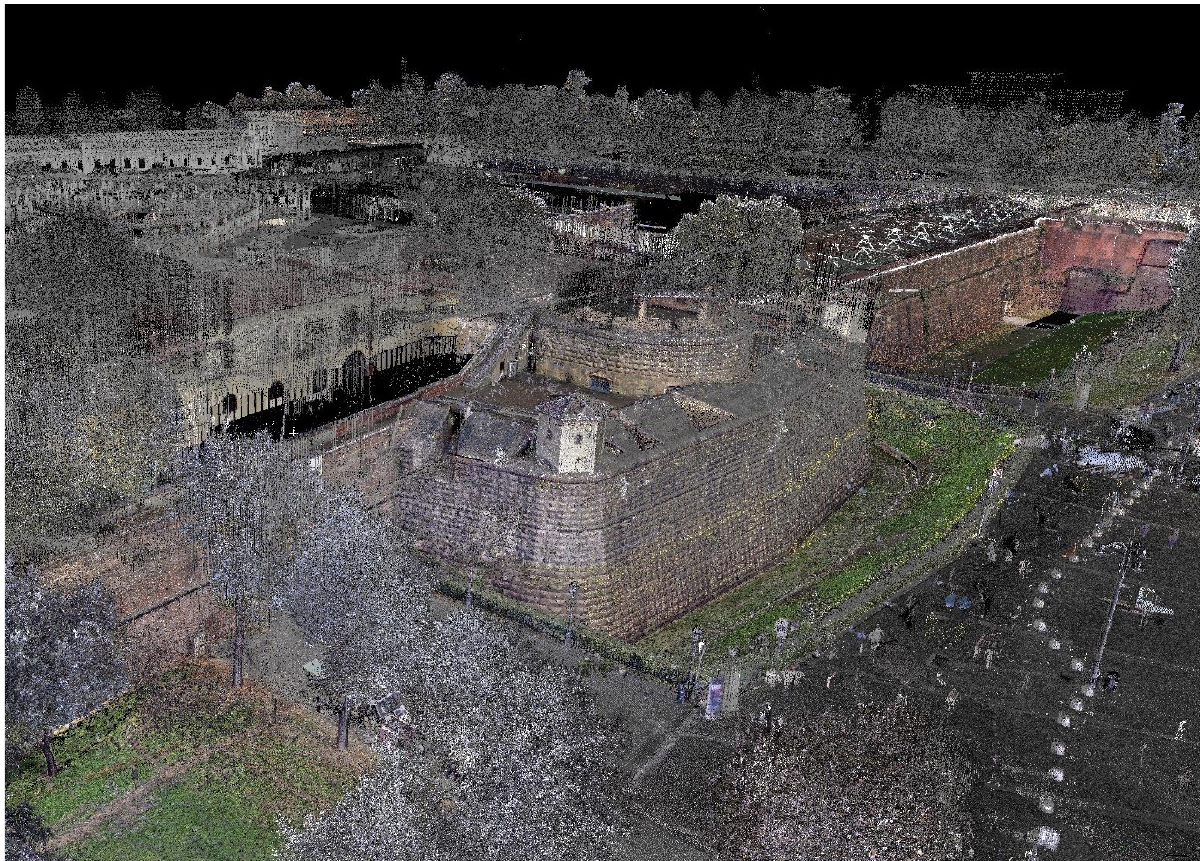
Figure 3. View of the fortress: the 3D point model comes from digital photogrammetry, TLS, mobile mapping